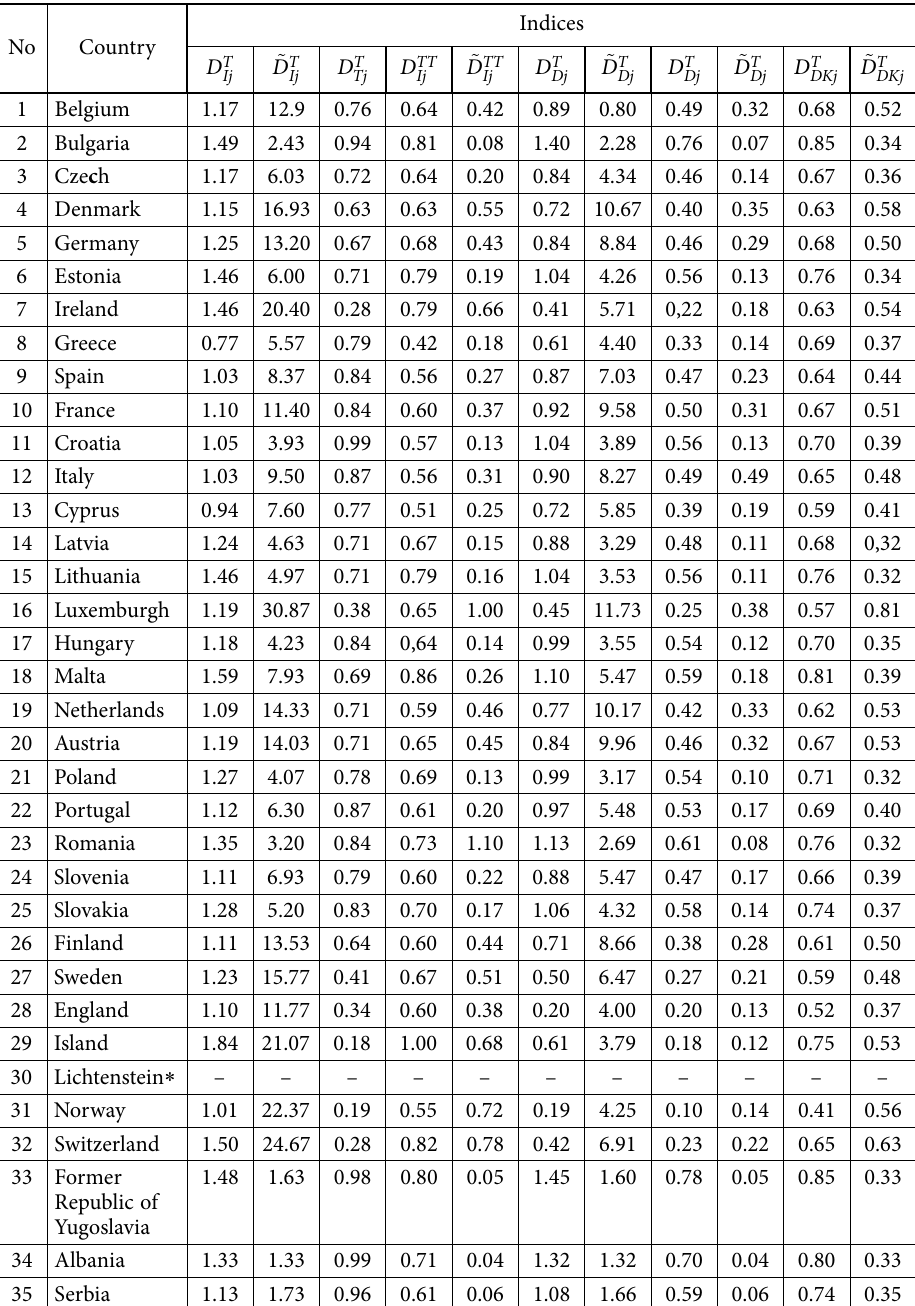
Table 3. Estimated values of indices of economic development of EU countries (source: compiled by authors) No